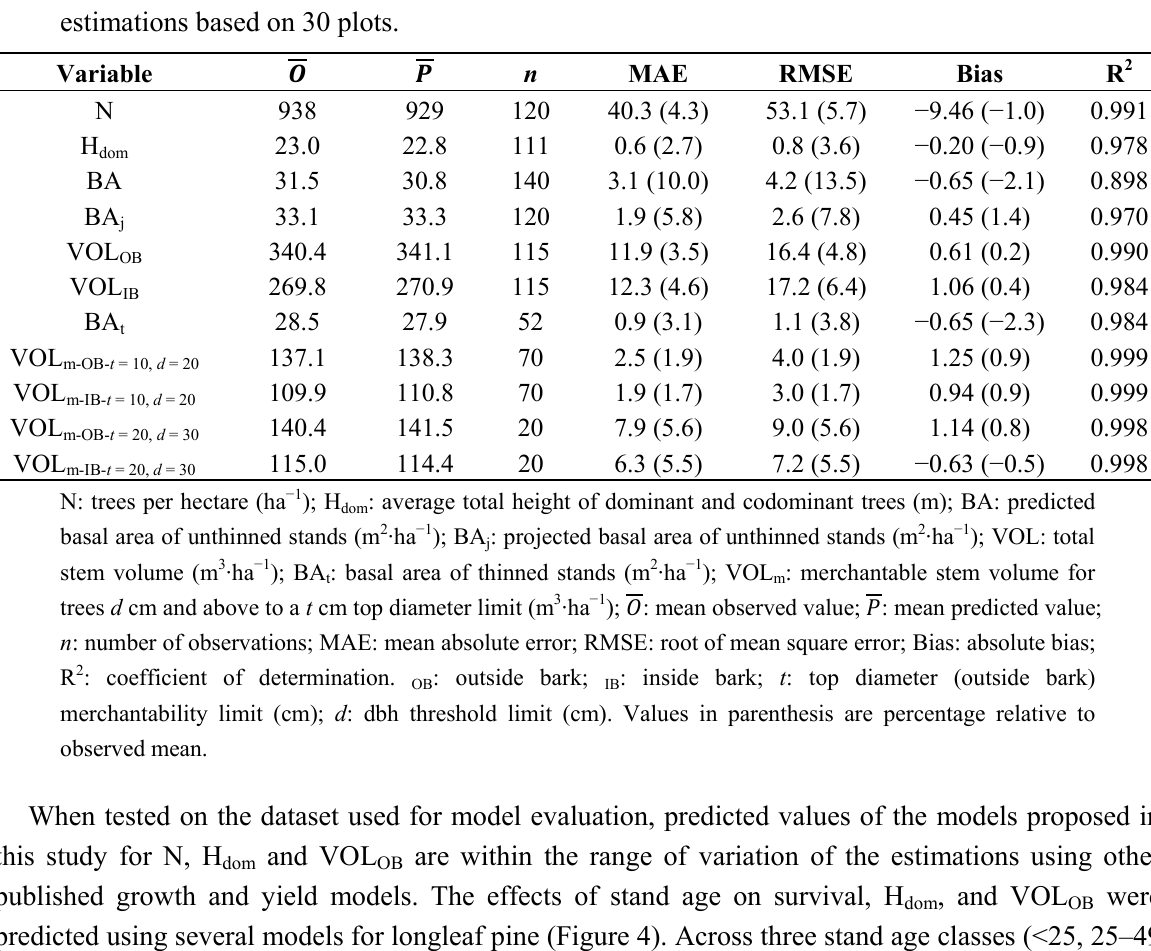
, BA, BA , VOL, and VOL dom t